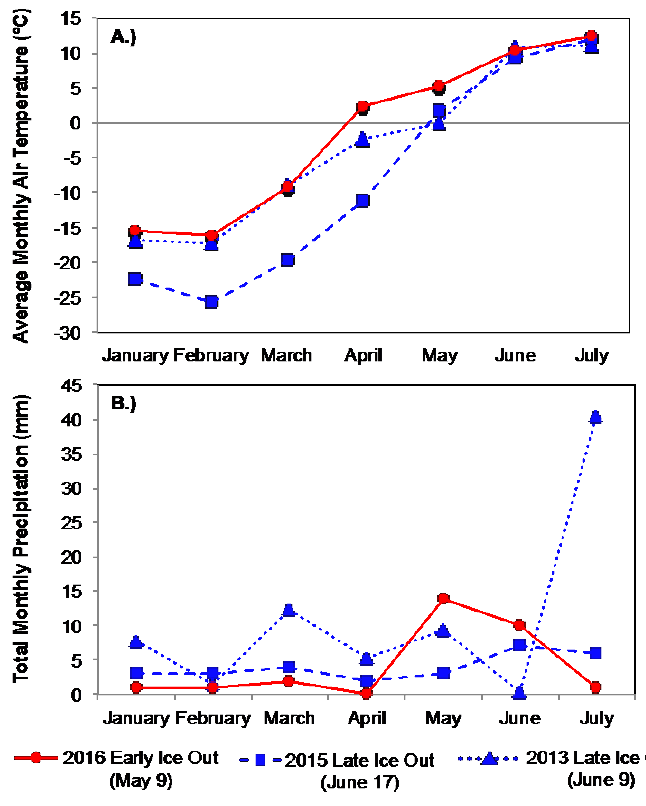
Figure 3. Arctic ( A ) average monthly air temperature in °C and ( B ) total monthly precipitation in mm for early and late ice-out years.